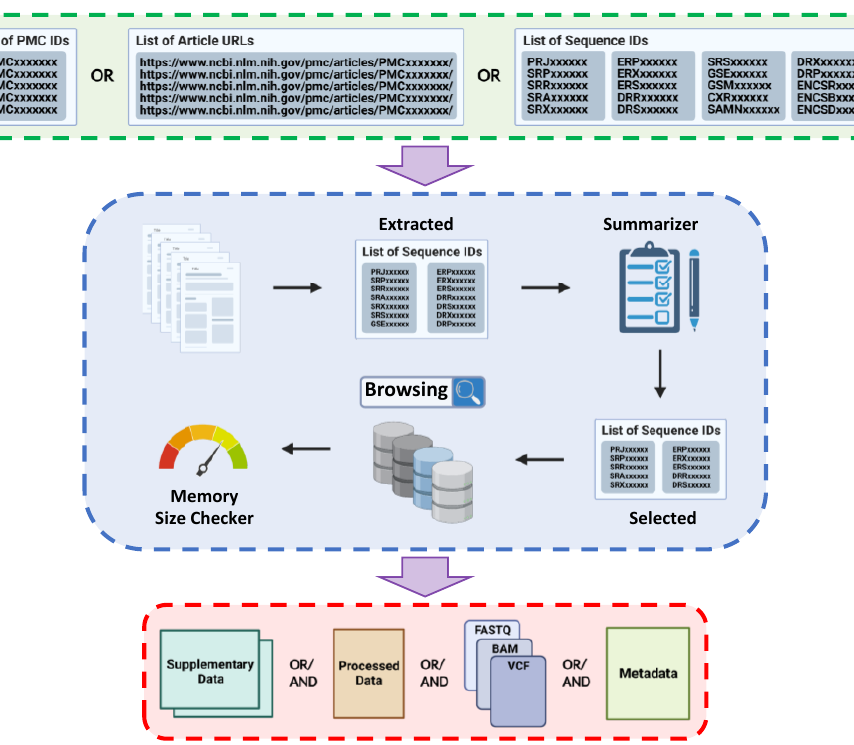
Figure 1. The architecture of KARAJ . Input and output file formats are shown by green and red boxes, respectively. The blue box represents the processing steps provided by KARAJ . The input to KARAJ is a list of either PubMed Central PMCIDs or URLs for articles. KARAJ then mines the text of corresponding articles for the accession numbers (Extracted list). Then, KARAJ generates a report summary of these accession numbers containing the information including number of samples, description, experimental design, and the sequencing technology. This report summary gives the user the opportunity to choose accession numbers that are of interest (Selected list). KARAJ fetches the header for data linked to these accession numbers and calculates the size of these data and checks with the local drive to ensure the availability of adequate space. When adequate local storage space exists, KARAJ downloads all files using a parallel framework powered by the Aspera protocol. KARAJ also accepts list of accession numbers as an input to retrieve sequence data. Image created with BioRender.com under the NX24GYLITA agreement number.